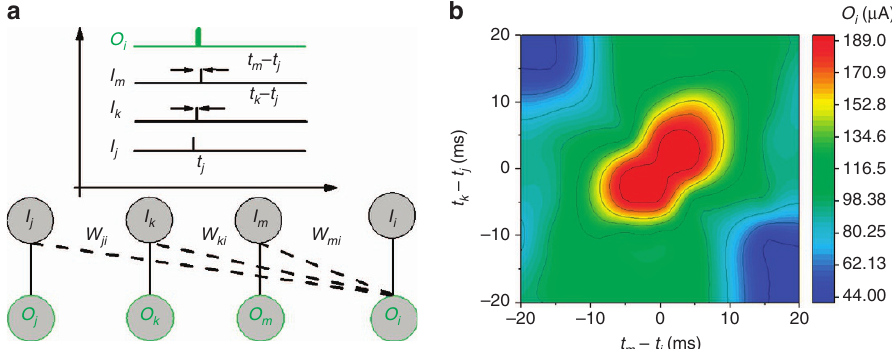
Figure 5 | Coincidence detection using soft connections between devices. ( a ) Schematic of the measurement protocol. A voltage pulse (amplitude of 0.5V, width of 10ms) is applied at three local inputs I j , I k , I m with variable time intervals t k (cid:3) t j and t m (cid:3) t j with respect to a reference time t j of the input I j . The output O i of the i th device is measured for different timing conditions. ( b ) Time correlation map of the output O i showing coincidence